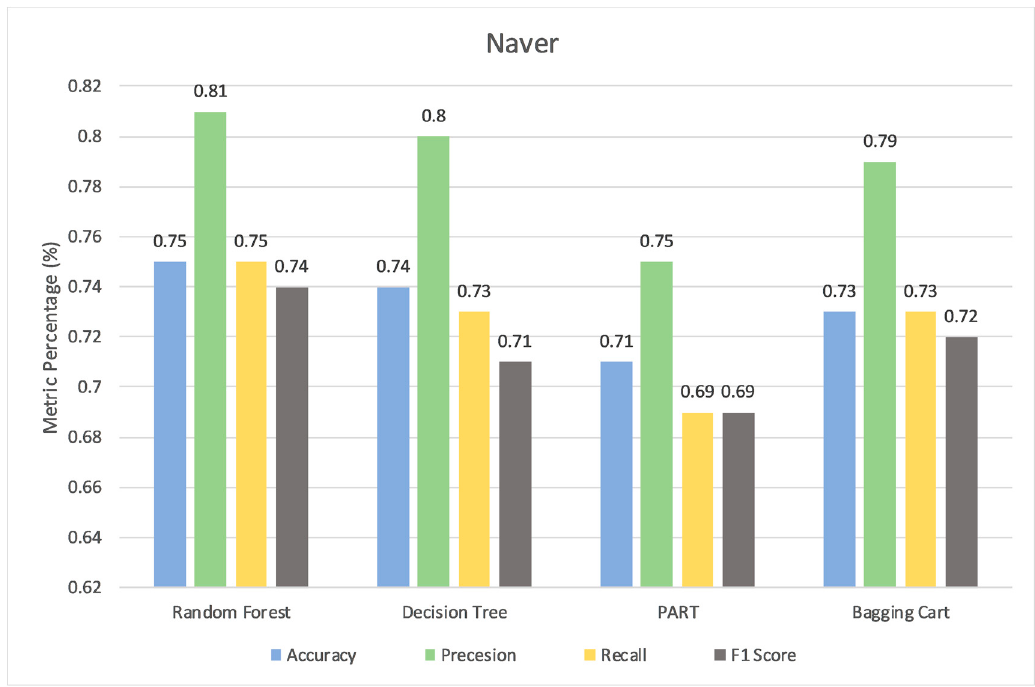
Figure 9. Evaluation result on Naver.